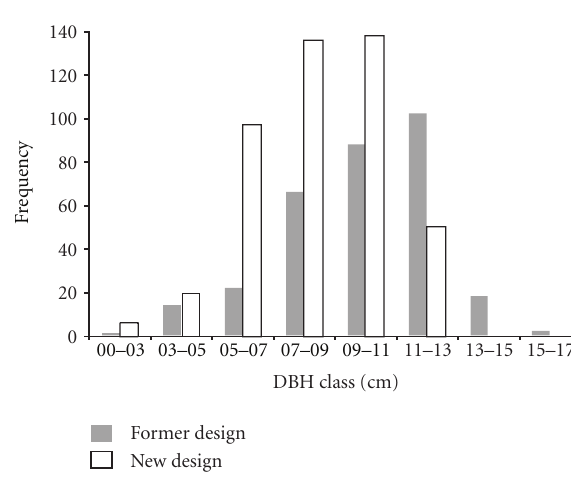
Figure 6: Comparative distribution of the DBH classes between the old and the new plantation